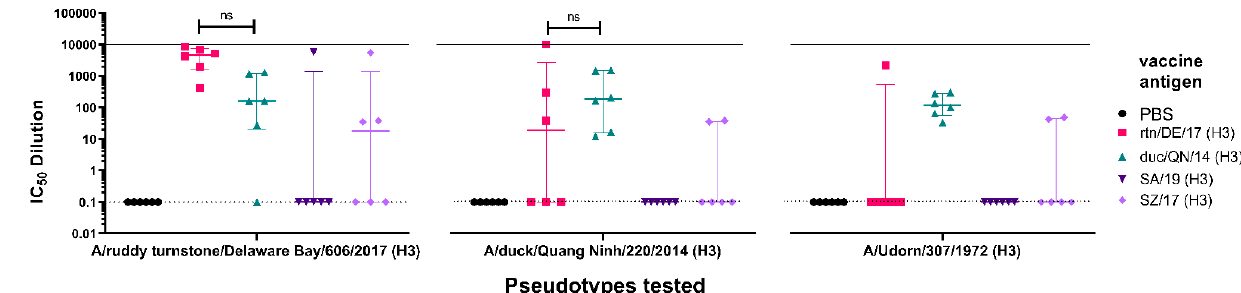
Figure 8. In vitro neutralizing activity as shown by IC 50 dilution of mouse sera vaccinated with avian and human pEVAC H3 vaccine antigens tested against homologous avian H3 PV and a representative human PV strain of H3. Four groups consisting of 6 mice each ( n = 6/group) were vaccinated with 50 µ g of pEVAC HA-A/ruddy turn-stone/Delaware Bay/606/2017 (H3) (rtn/DE/17) (pink square) or HA-A/duck/Quang Ninh/220/2014 (H3) (duc/QN/14) (green triangle), HA-A/South Australia/34/2019 (H3) (SA/19) (violet inverted triangle), and HA-A/Switzerland/8060/2017 (H3) (SZ/17) (purple diamond), respectively. An additional group of mice was vaccinated with PBS (negative control group) ( n = 6). Terminal bleeds (70 dpi) were tested against H3 PV strains: 2 homologous avian PV, rtn/DE/17 and duc/QN/14, and one human PV, A/Udorn/307/1972 (UD/1972), as shown in the x-axes. For all plots, the median and interquartile range of individual mouse serum samples per immunization group are shown. The solid line indicates an assigned maximum IC 50 dilution of 10,000 showing 100% neutralization and the broken line shows an assigned baseline level of 0.1 indicating 0% neutralization (cell only mean). Comparisons of no significant difference (ns: p > 0.05) against the homologous PV are shown in